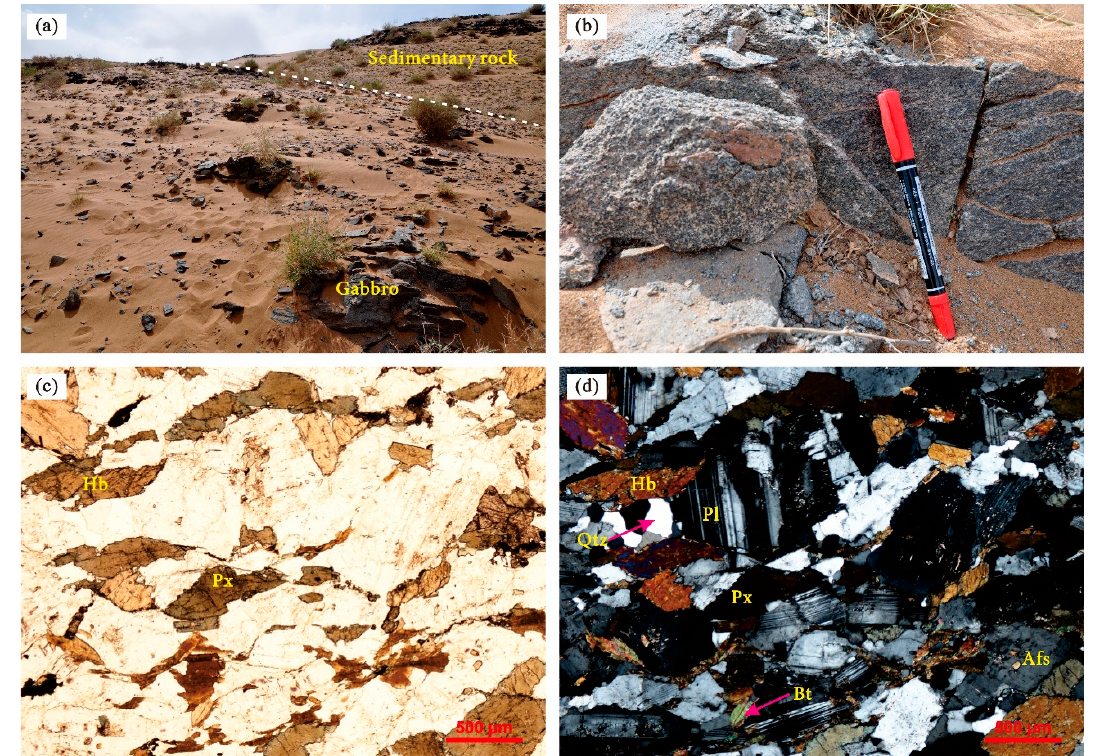
Figure 3. Field photographs and photomicrographs showing petrographic features of the hornblende gabbro from the Baogeqi gabbro plutonthe Baogeqi gabbro: ( a ) The intrusive contact relationship between the Baogeqi gabbro plutonthe Baogeqi gabbro and Amushan Formation sedimentary rocks; ( b ) Outcrop of the Baogeqi gabbro plutonthe Baogeqi gabbro; ( c ) The photomicrograph of the hornblende gabbrothe Baogeqi gabbro in plane polarized light, and ( d ) The photomicrograph of the hornblende gabbrothe Baogeqi gabbro under cross polarized light. Mineral abbreviations: